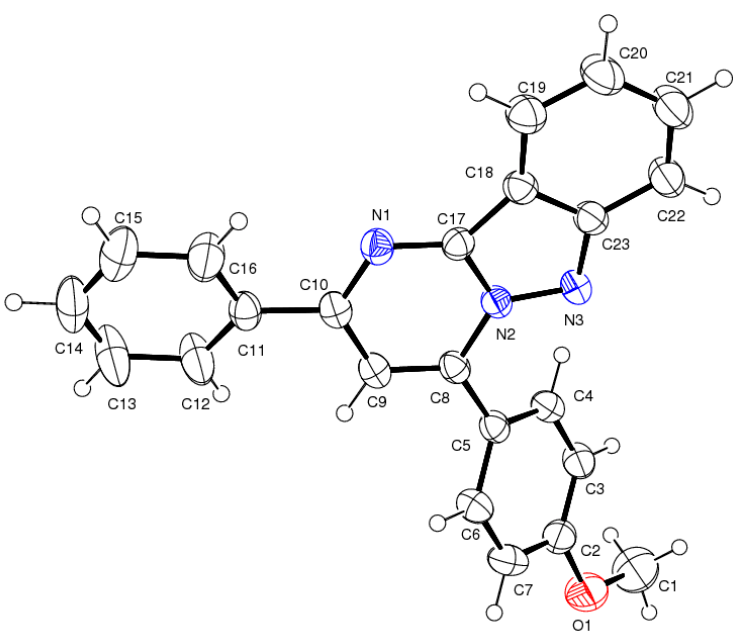
Figure 1. The ORTEP representation of compound 4d .